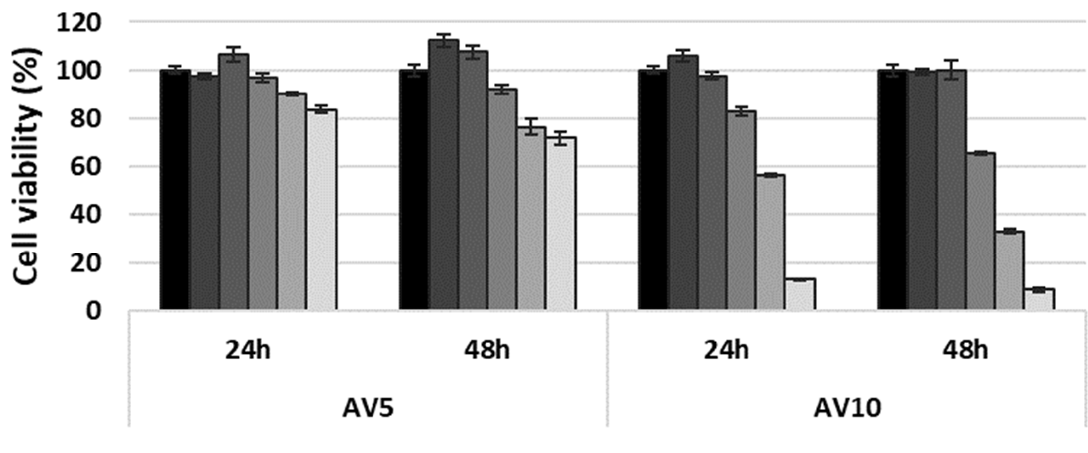
Figure 5. Viability of L929 murine fibroblasts cultivated in the presence of different concentrations of AV5 and AV10, for 24 h and 48 h, evaluated by the MTT assay. Samples were reported to untreated cells (control), considered to have 100% viability. Data were expressed as mean values ± SD (n = 3). Fluorescence microscopy was used to evaluate cell morphology and viability after the staining of live cells with calcein (green) and dead cells with ethidium homodimer (red). L929 murine fibroblasts maintained their viability after 48 h of treatment with